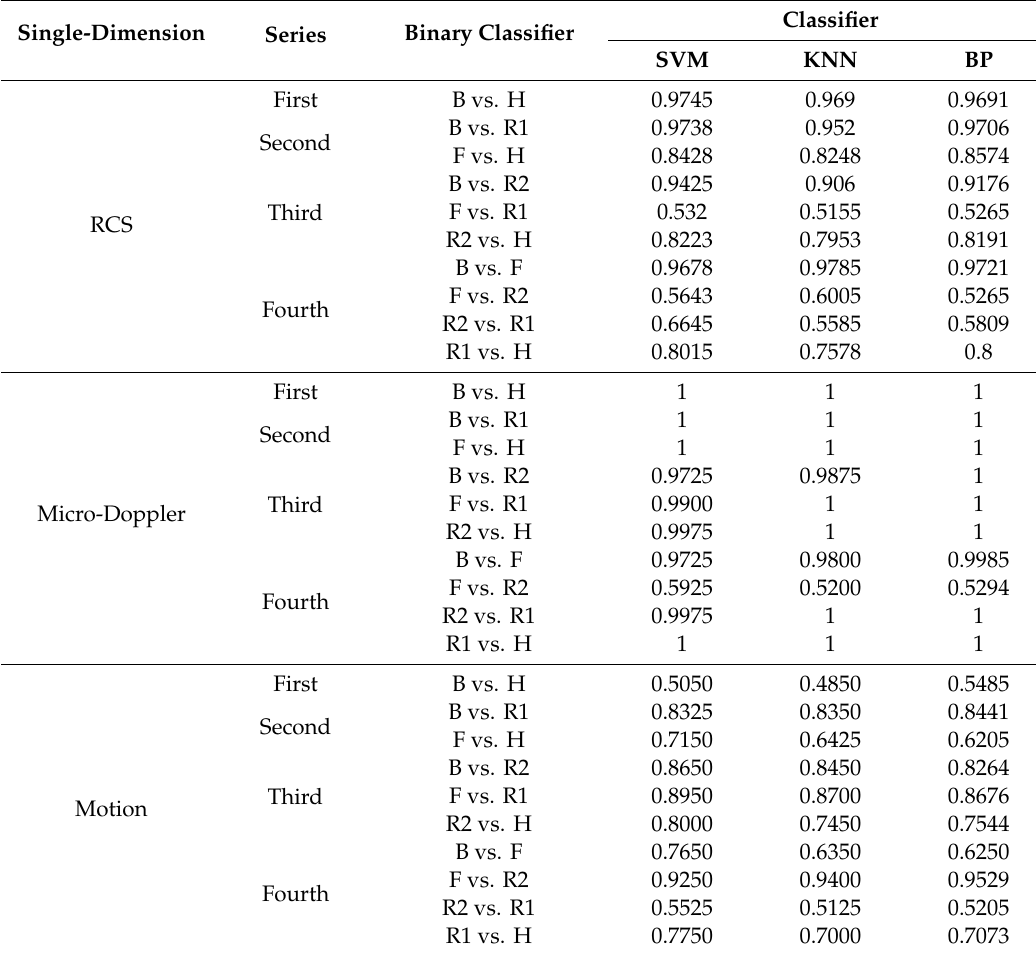
Table A2. The classification accuracy rates of each binary classifier in three dimensions of RCS, micro-Doppler and